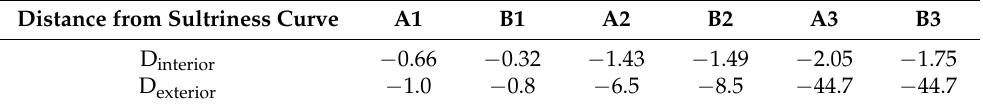
Table 7. Distance D from sultriness curve.